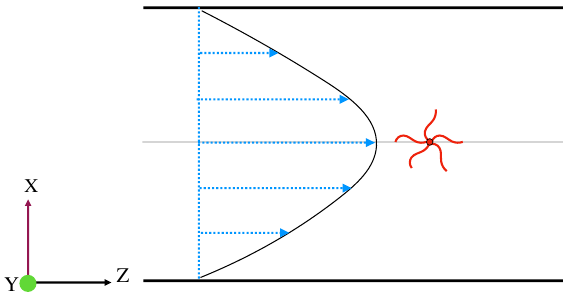
Figure 1. Schematic representation of the channel geometry and resulting flow